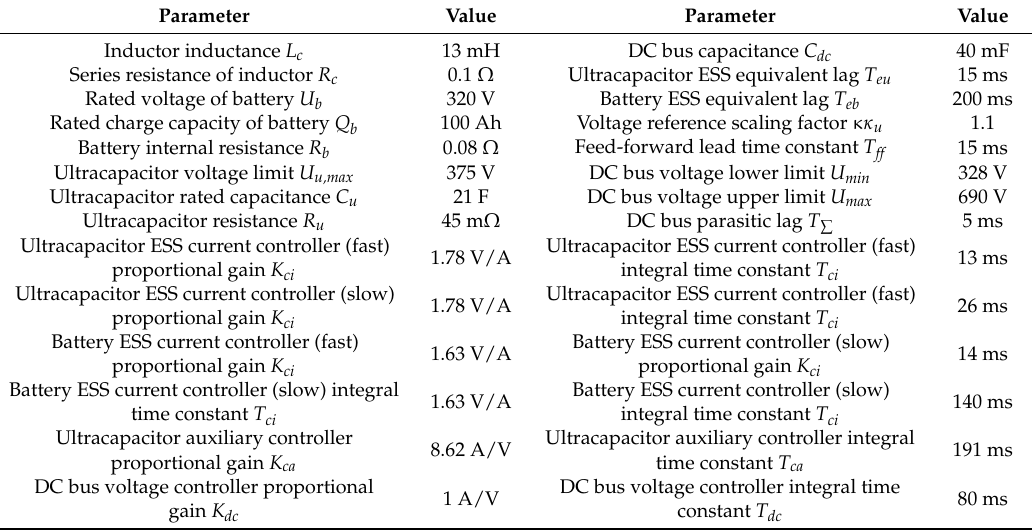
Table 2. EV power-train simulation model parameters.